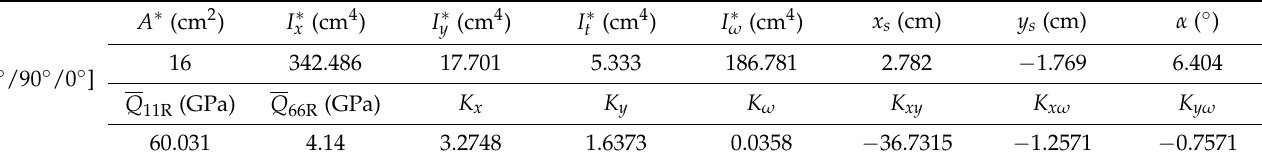
Table 2. Example 2’s cross-section properties. Four different mesh configurations, each consisting of two, four, eight, and sixteen beam elements, are used to analyze the lateral-torsional buckling mode in Figure 6b. Since